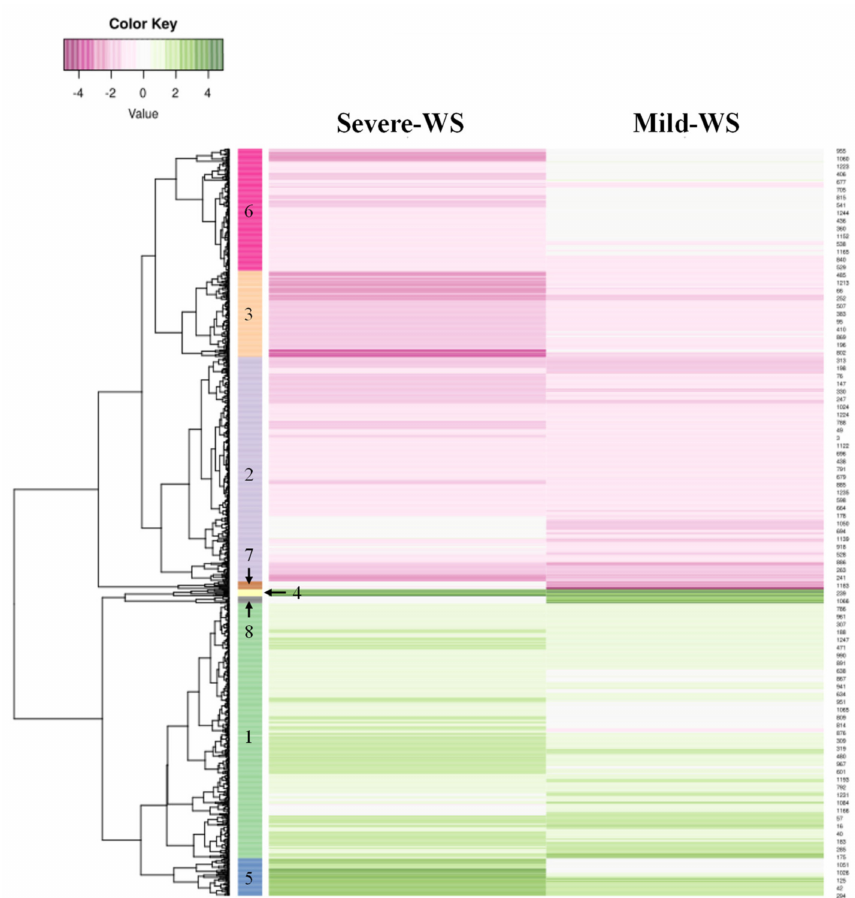
Figure 6. Hierarchical clustering (HCL) of differentially expressed genes (DEGs) in the microarray analysis of ‘Dusa’ avocado rootstock subjected to two different levels of water stress: mild-WS (50% of Fc) and severe-WS (25% of